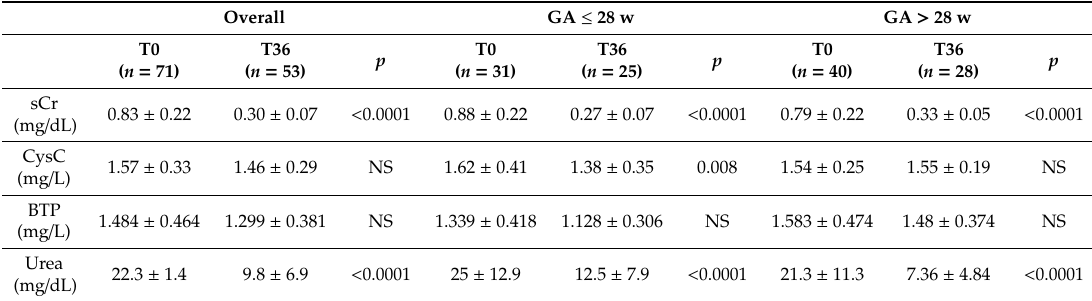
Table 4. Biochemical data in the overall population and in subjects with GA ≤ or > 28 weeks, at T0 and